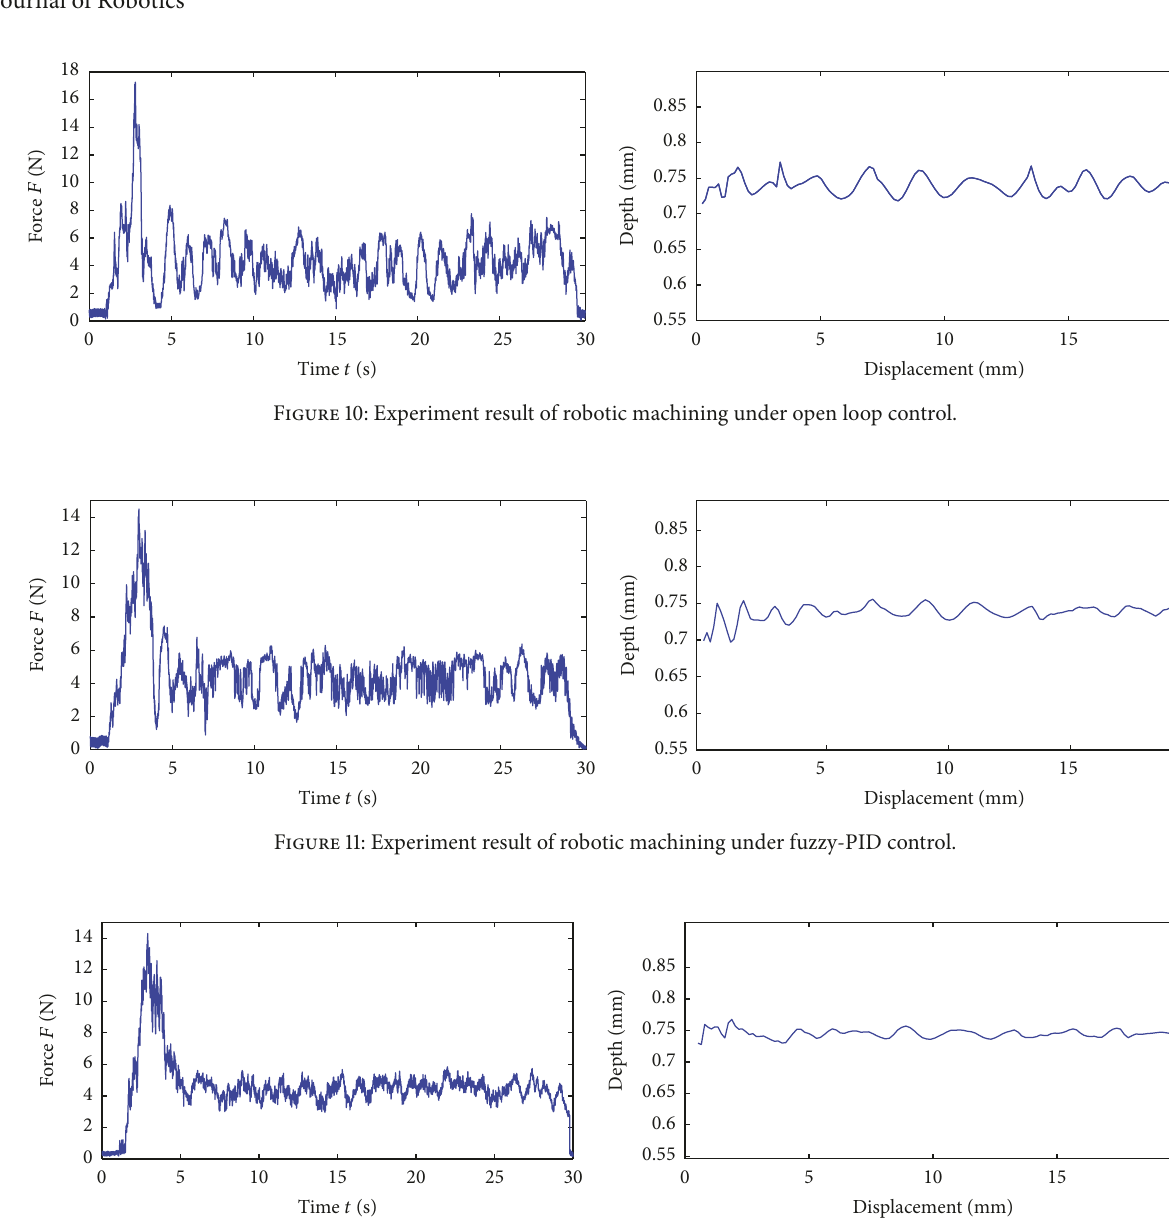
Figure 12: Experiment result of robotic machining under fuzzy-sliding mode